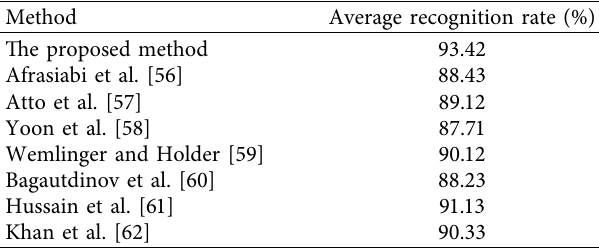
Table 1: Compared with other approaches on the TV human interaction dataset.